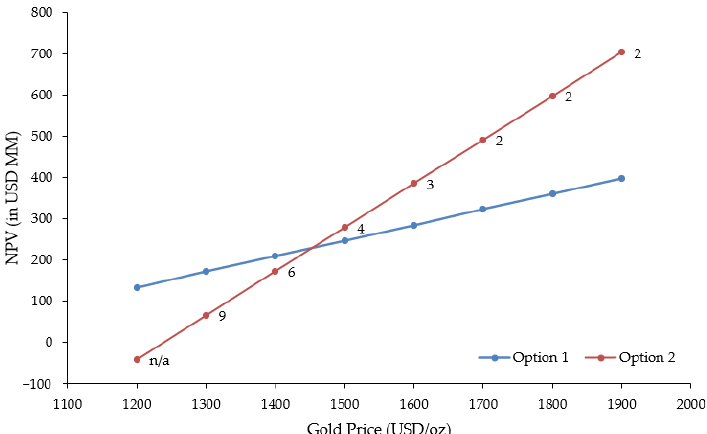
Figure 12. Plot showing the relative trade-off between Options 1 and 2 for gold prices ranging from USD 1200/oz to USD 1900/oz. The breakeven point for bringing Mine II online occurs at a price of ~USD 1450/oz, with a payback period of ~5 years (data labels).